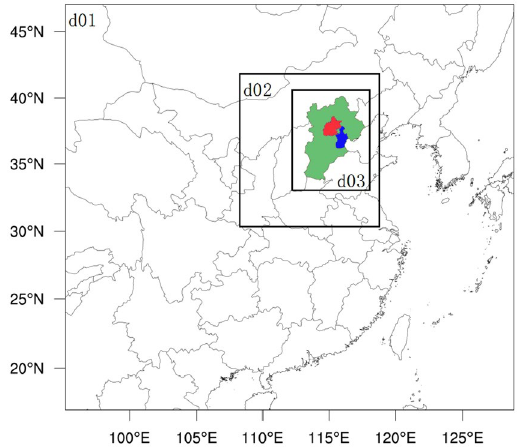
Figure 1. Triple nesting domains for computational implementation of the CMAQ model: d01 covers most of China and part of East Asia with the resolution of 36 × 36 km; d02 covers the Northern China Plain (NCP) with the resolution of 12 × 12 km; d03 covers the Beijing-Tianjin-Hebei (BTH) region with the resolution of 4 × 4 km. Green, orange, and blue colors represent Heibei, Beijing, and Tianjin, respectively. The maps were created by NCAR Command Language (NCL) (http://www.ncl.ucar.edu/).